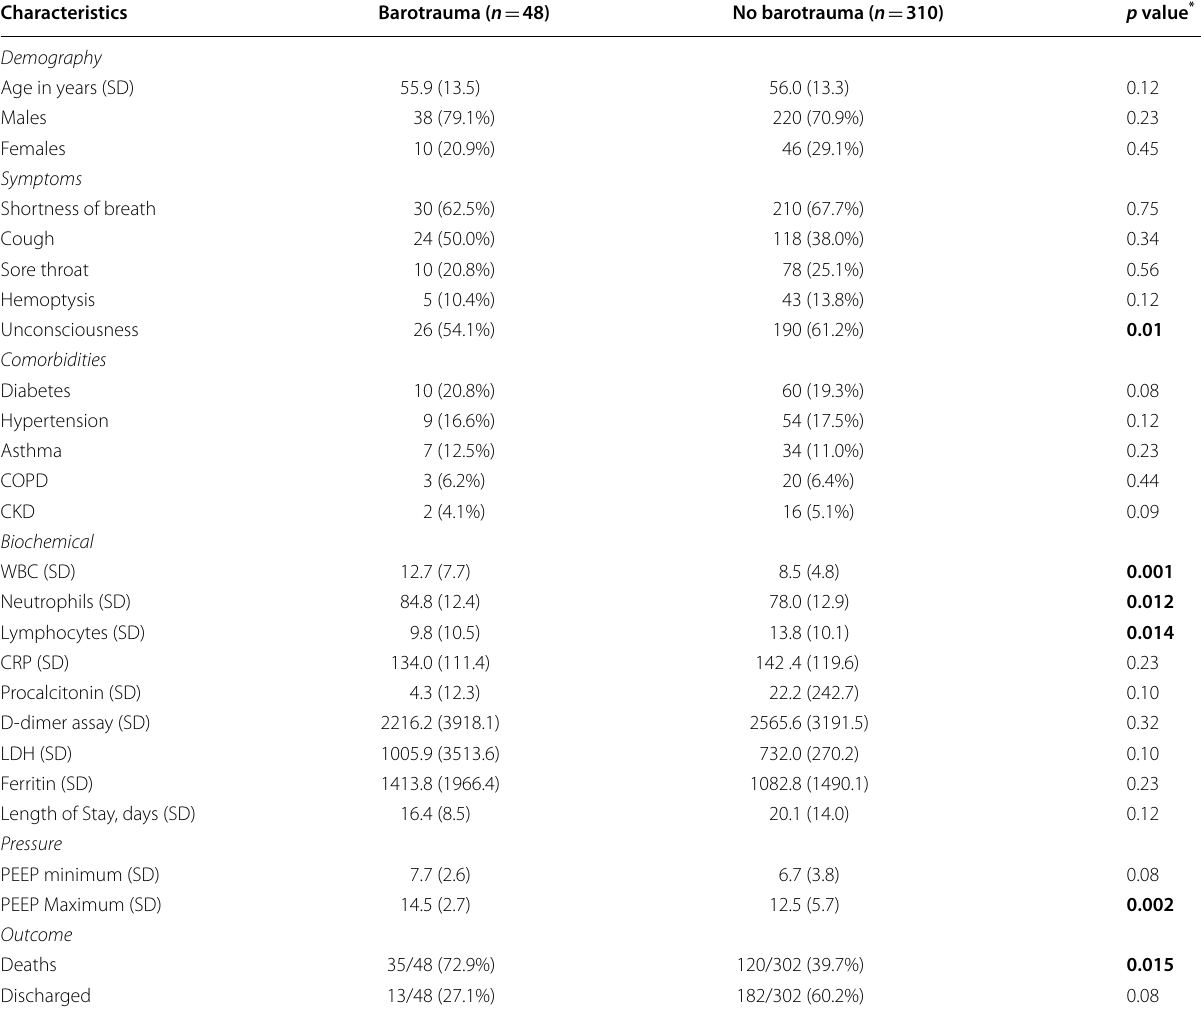
Table 1 Demographic, clinical, and biochemical characteristics according patients with or without barotrauma